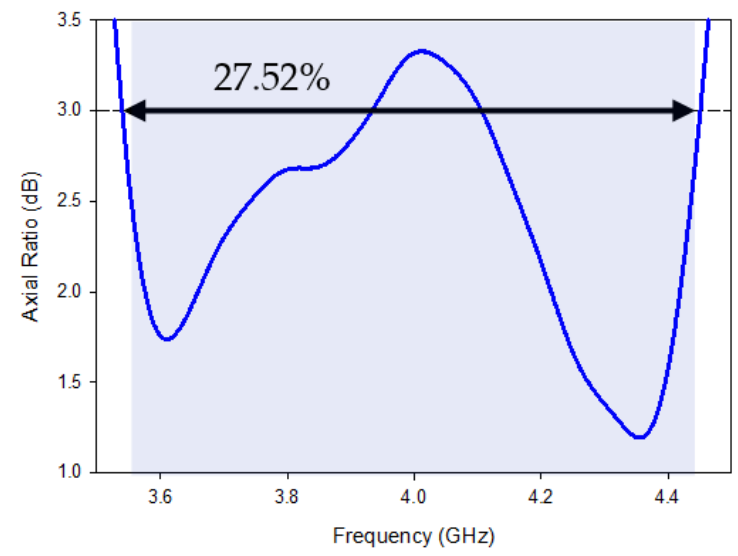
Figure 8. Axial ratio with parasitic patch.